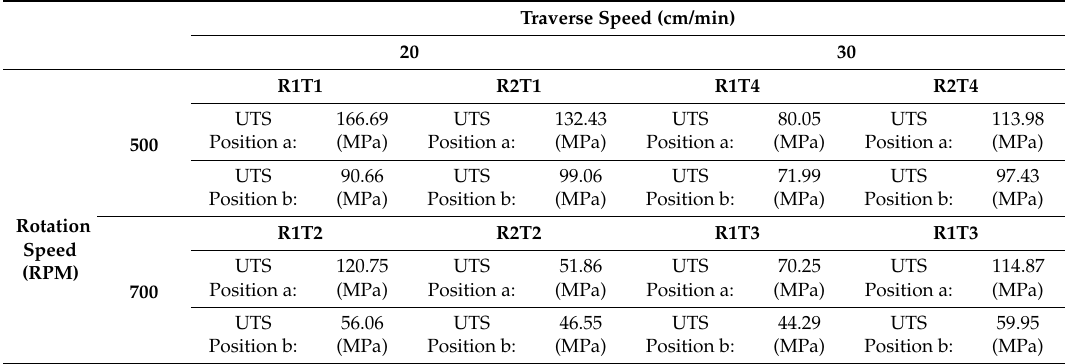
Table 5. Summary of the UTS values obtained for each welded joint for the specimens a and b.